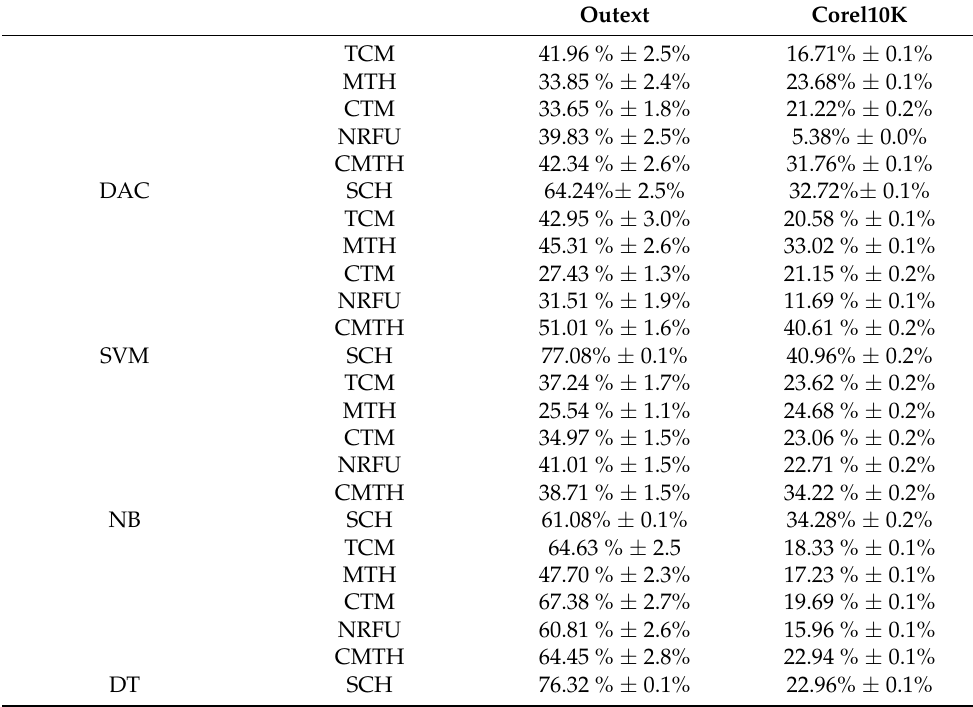
Table 5. Results obtained by classifying images from each dataset using DAC, SVM, NB and